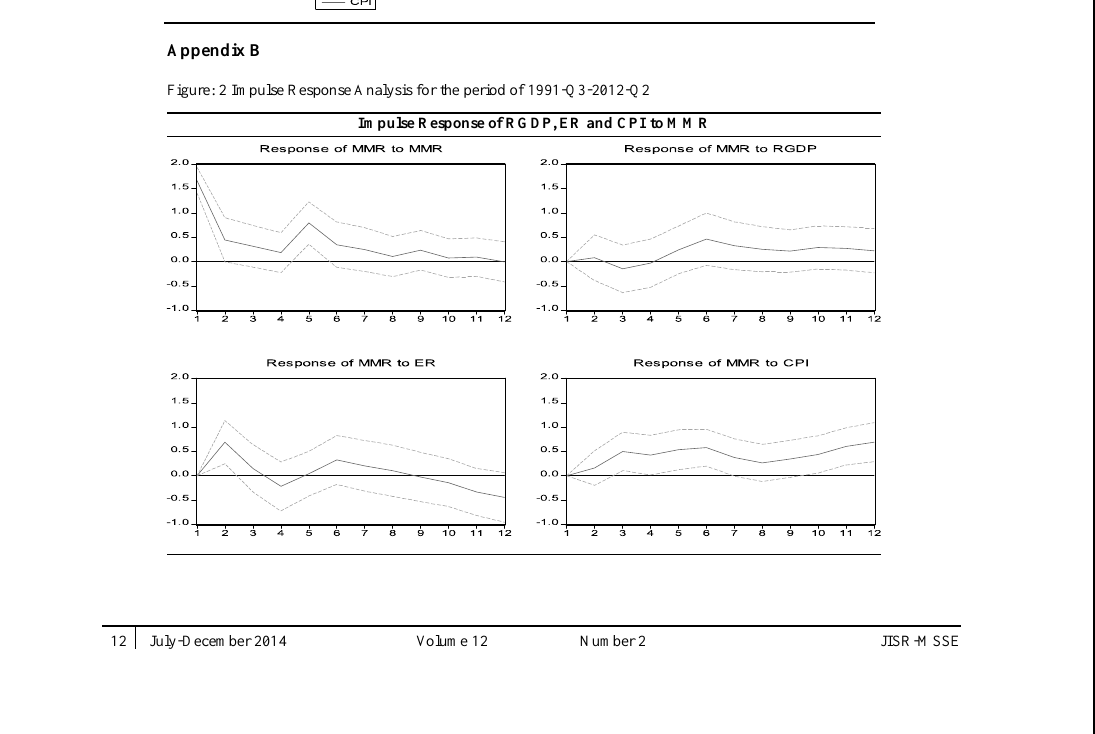
Figure: 2 Impulse ResponseAnalysis for the period of 1991-Q3-2012-Q2 Impulse Response of RGDP, ER and CPI to